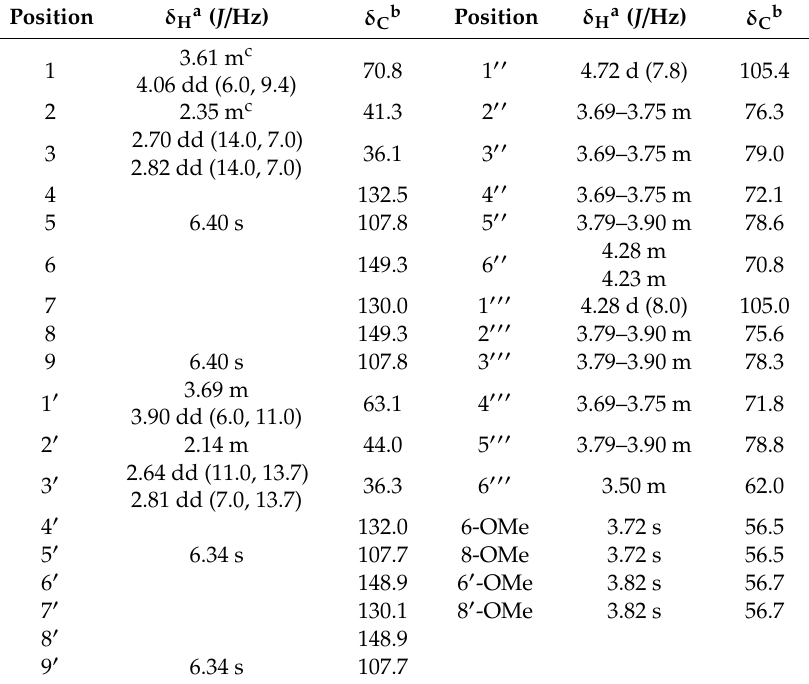
Table 1. 1 H and 13 C NMR spectroscopic data for compound 16 in methanol- d 4 . Position δ Ha ( J / Hz) δ Cb Position δ Ha ( J /